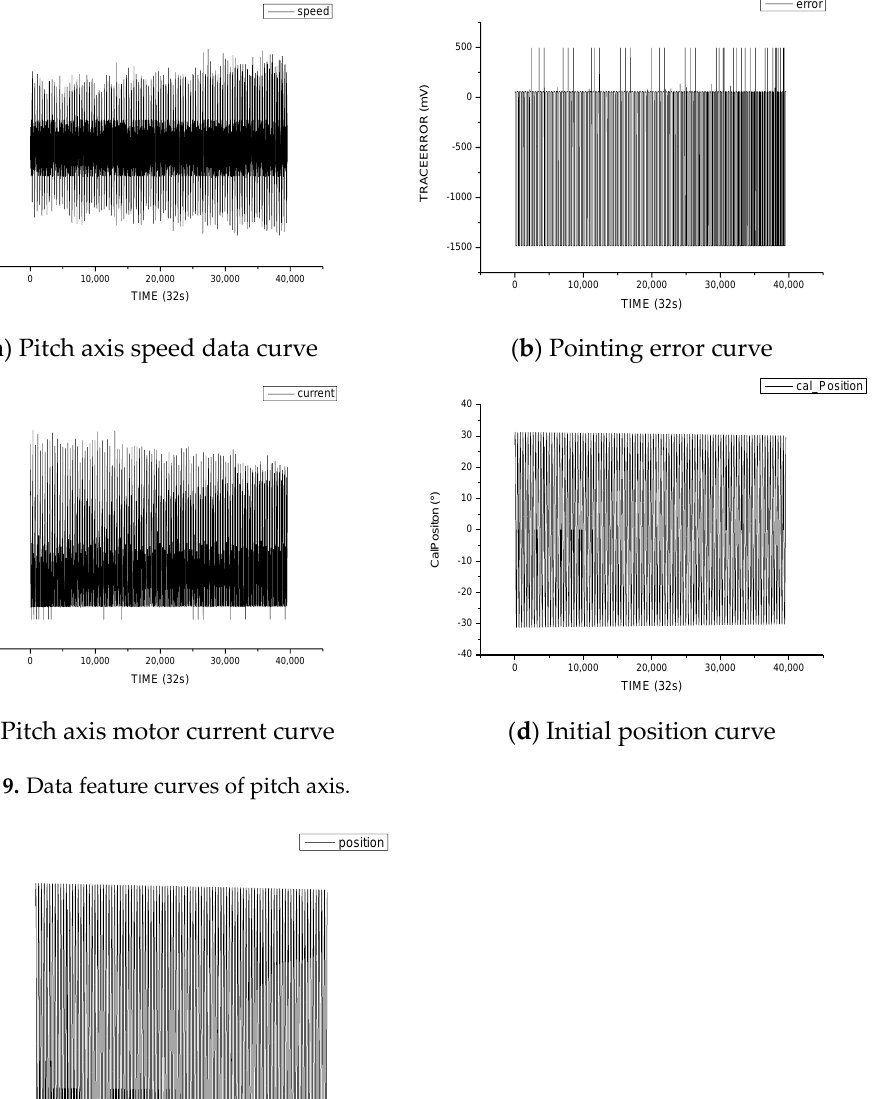
Figure 8. Prediction processing.